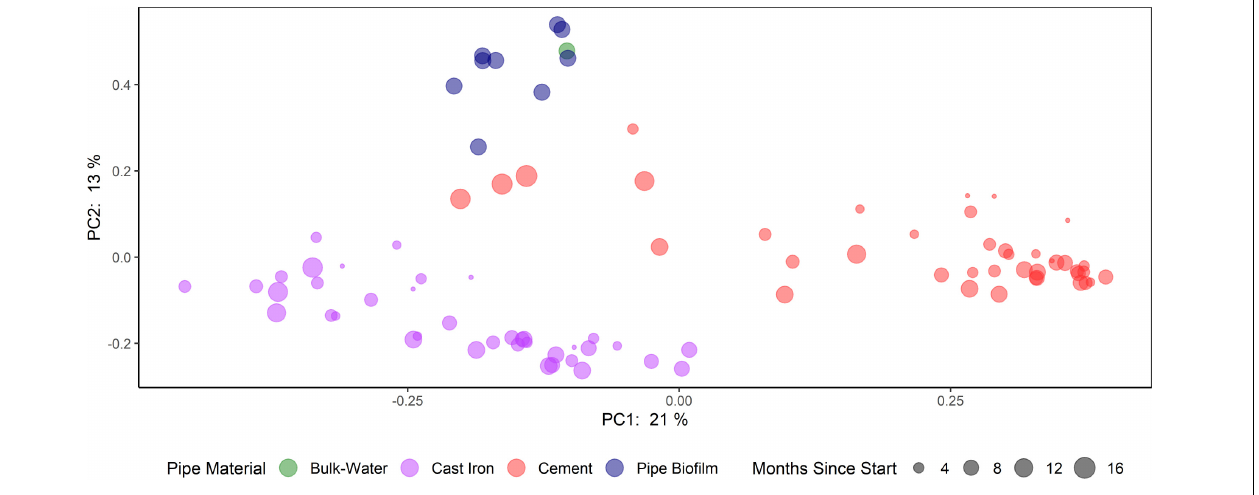
FIGURE 5 | Comparison of bacterial communities in annular reactors (cast iron and cement) and drinking water distribution systems (bulk water and pipe biofilm). Principal coordinate analysis (PCoA) plots of the Bray-Curtis dissimilarities according to their sample type (color) and months since start of study